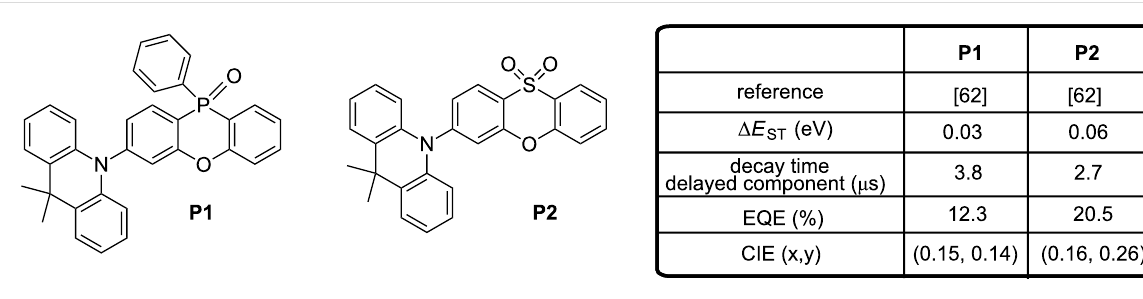
2016 [62]. Prior to this work, phenoxaphosphine oxide deriva- tives were mostly studied for the design of flame-retardants [63] or as chiral molecules for fullerene recognition [64-66]. Simi- larly, the scope of applications of phenoxathiin dioxide ranged from antimicrobial activity [67] to the use as inhibitor for Hepatitis C virus infection [68]. Here, in the context of OLEDs, Lee et al. reported two blue TADF emitters, P1 and P2 (see Figure 10), containing a phenoxaphosphine oxide or a phenoxa- thiin dioxide acceptor covalently linked to a dimethylacridan